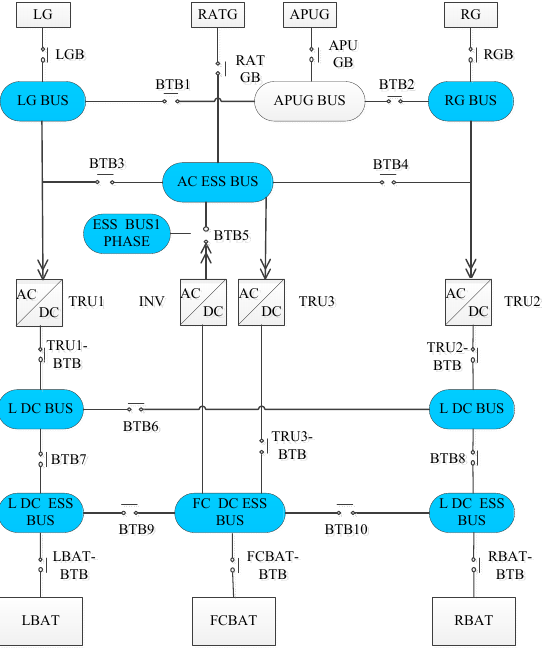
Figure 1. Typical architecture of an AEPS.